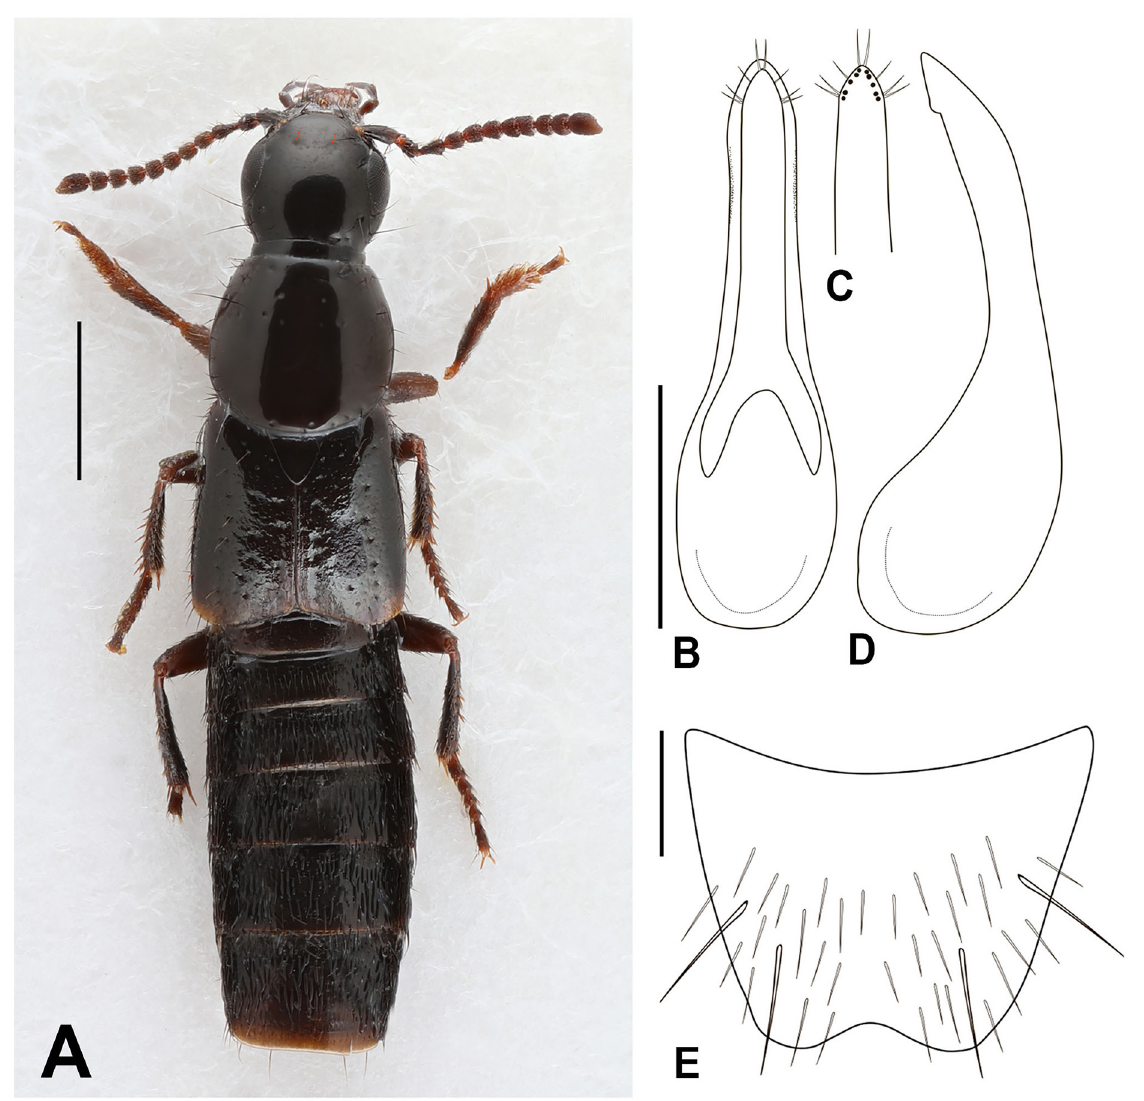
Fig. 1. Quedius gissaricus sp. nov., holotype (ZIN). A . Habitus (interocular punctures indicated by red arrows). B–D . Aedeagus. B . From parameral side. C . Apical portion of paramere (underside). D . Median lobe (laterally). E . Sternite VIII. Scale bars: A =1 mm; B–E = 0.5